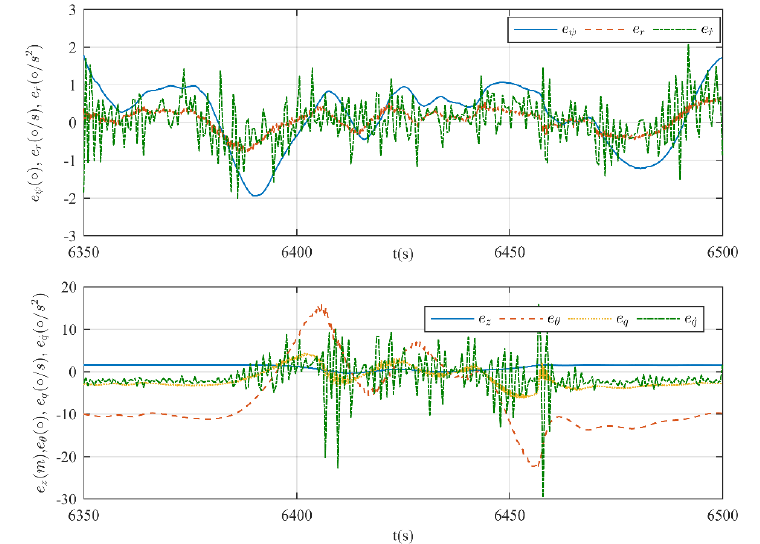
Figure 16. Evolution of errors in every loop. Errors in heading control (top) and errors in depth control (bottom).